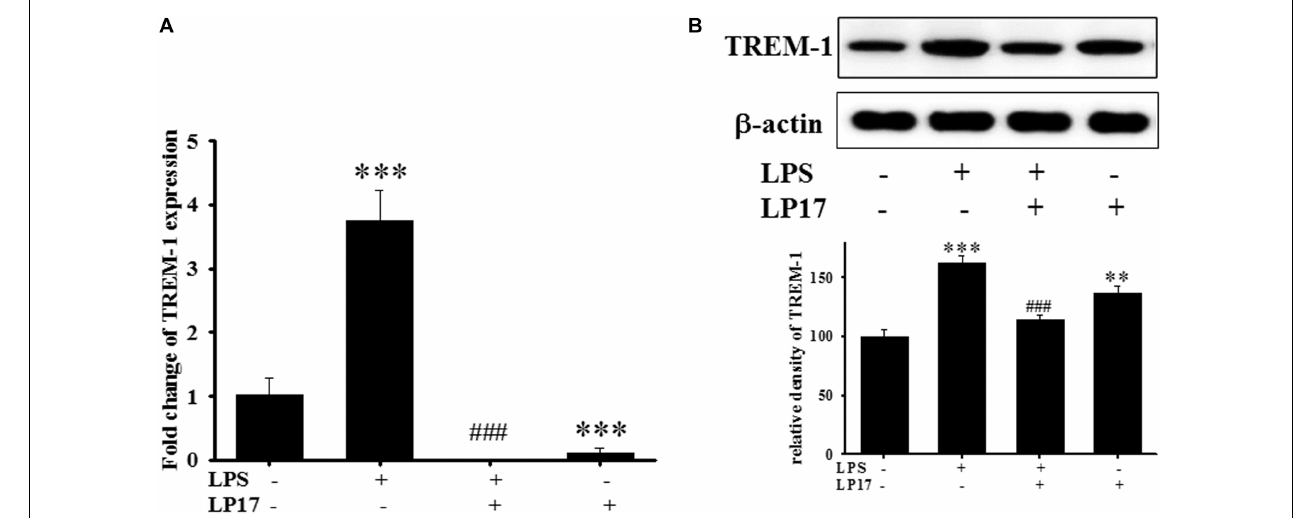
FIGURE 1 | The treatment of LP17 for 16 h attenuated LPS-induced upregulation of TREM-1 mRNA and protein expressions in BV2 murine microglial cell line ( n = 4/group). As shown on (A) quantitative PCR, (B) at the protein level by Western blotting. Co-treatment with 10 µ g/ml LP17 significantly attenuated the LPS-induced upregulation of TREM-1 in mRNA and protein level. The bars represent the mean ± SEM. The data were analyzed using two-way ANOVA. ∗∗ P < 0.05; ∗∗∗ P < 0.001 versus the control group; ### P < 0.001 versus the LPS